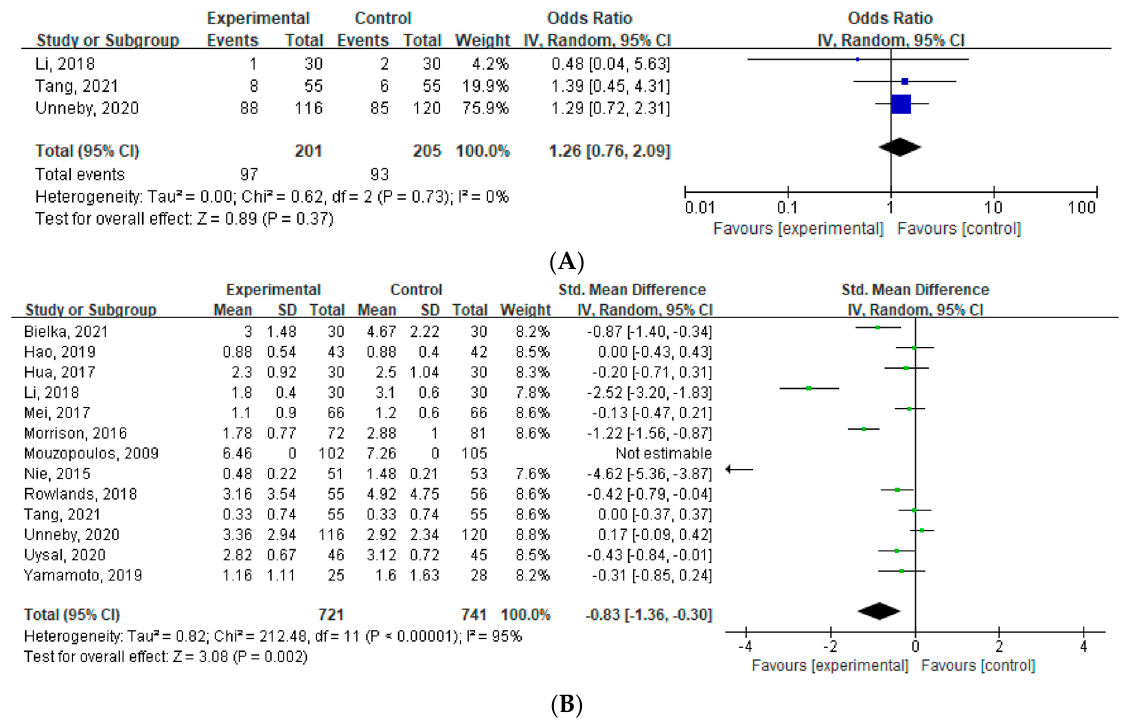
Figure 4. Forest plot [16,18,19,28,30–34,36–39]. ( A ) Effect of a peripheral nerve block on postoperative delirium at postoperative day seven. ( B ) Effect of a peripheral nerve block on postoperative pain. IV: inverse variance.